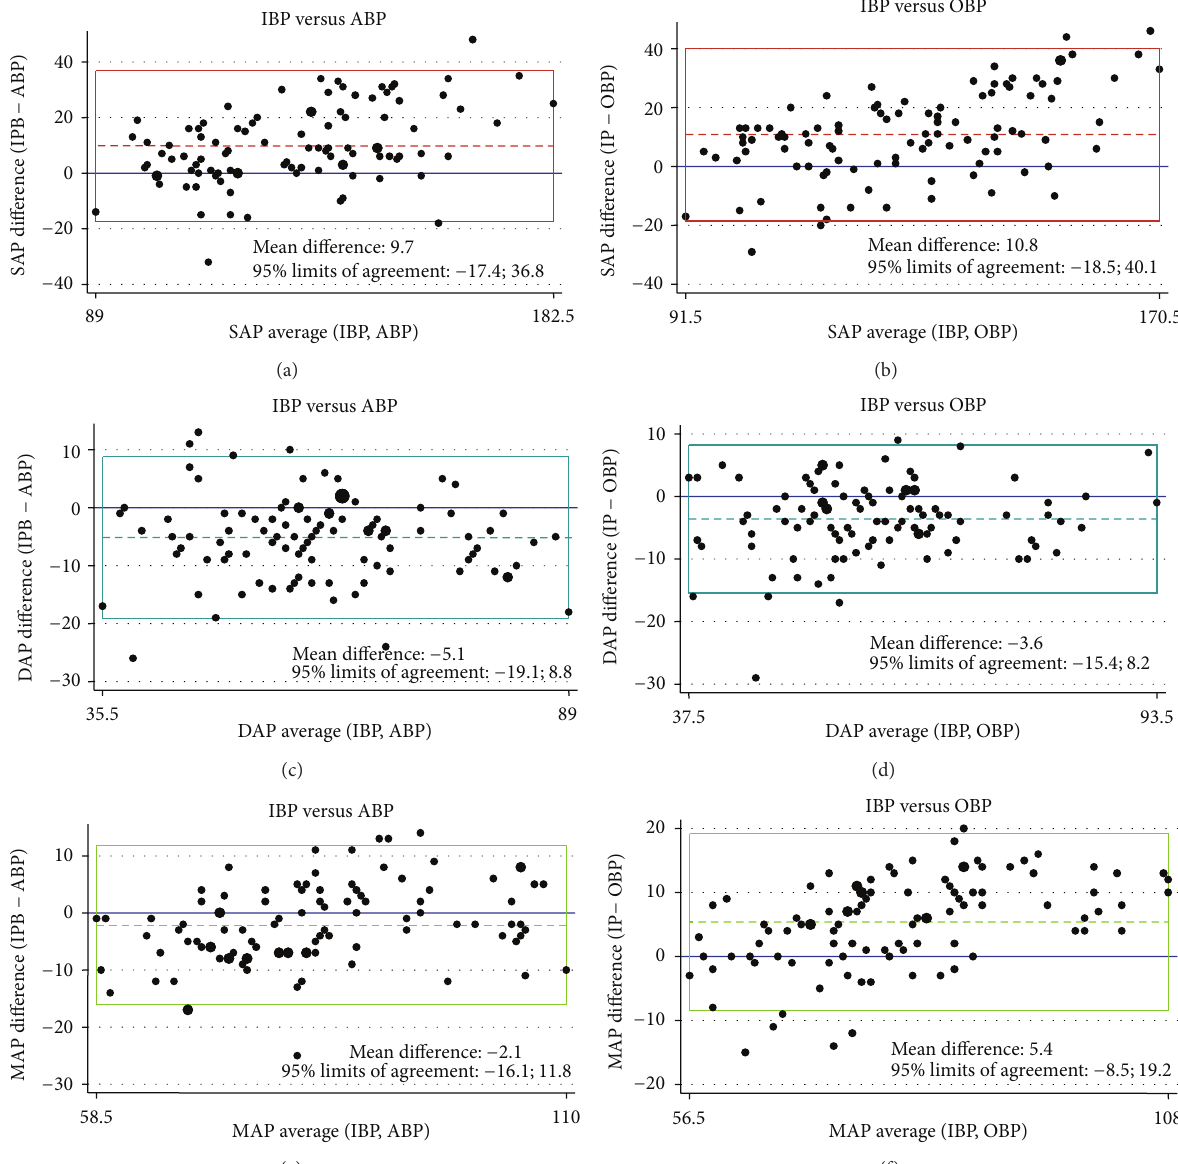
Figure 2: Bland-Altman analysis of theagreement between systolic(SAP), diastolic(DAP), and mean (MAP)arterial pressurein comparisons between direct-invasive (IBP) and, respectively, auscultatory-aneroid (ABP) and oscillometric automated (OBP) methods. The dashed line represents the mean bias; the upper and lower limits of the box represent the 1.96 ± SD limits of agreement.